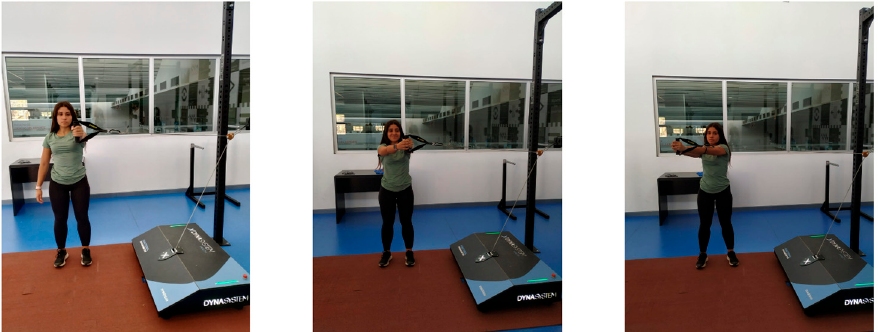
Figure 1. Assessment of horizontal cable woodchop exercise using a functional electromechanical dynamometer.